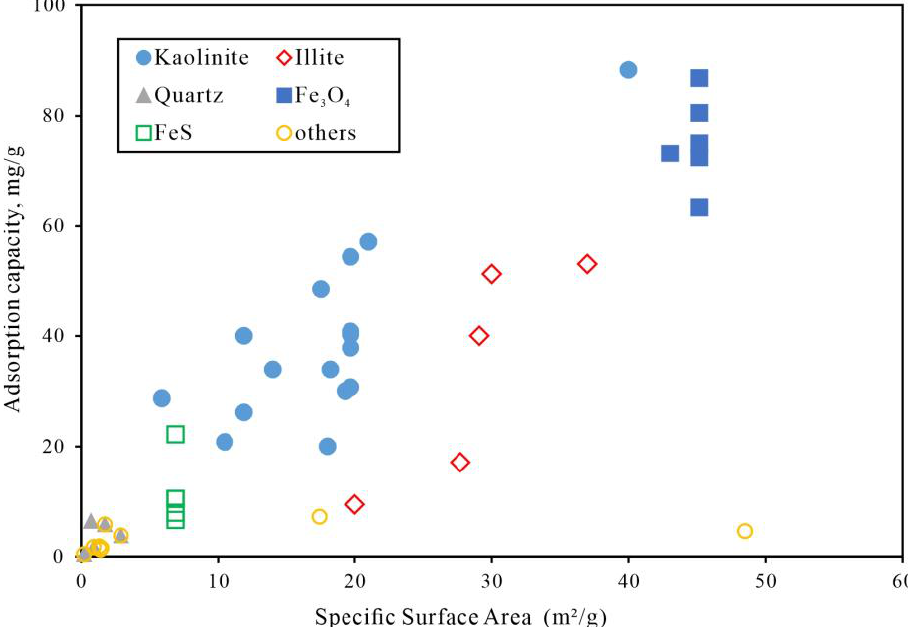
Figure 7. Diagram of specific surface area and adsorption capacity of minerals and reservoir rocks (Adapted with permission from Ref. [21]. 2016, Elsevier).